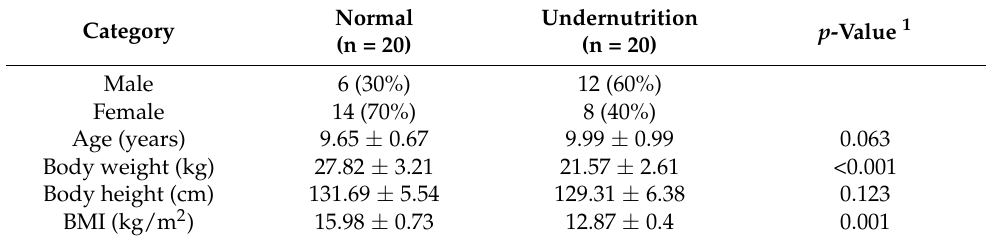
Table 1. Characteristics of 40 Indonesian subjects in this